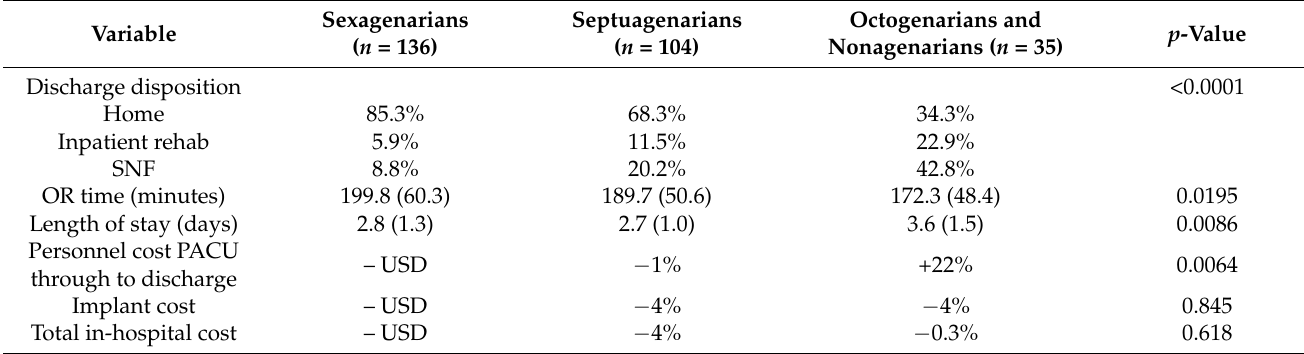
Table 2. Comparing the outcomes and costs for revision total hip arthroplasties between sexagenarians,